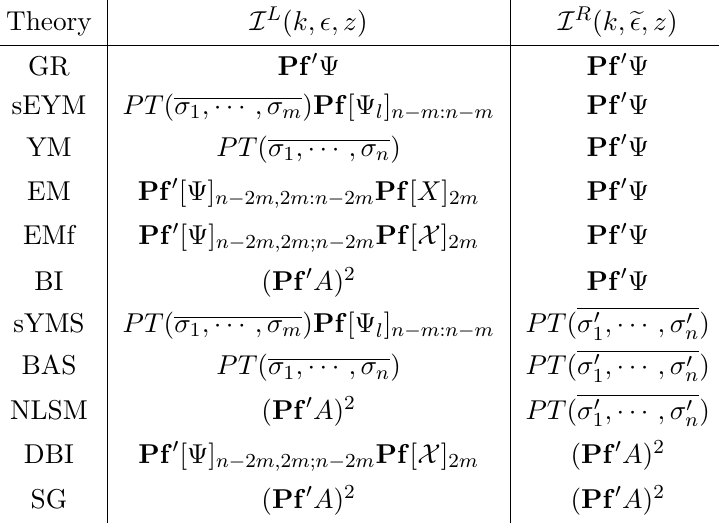
Table 1 . Form of the integrands for various